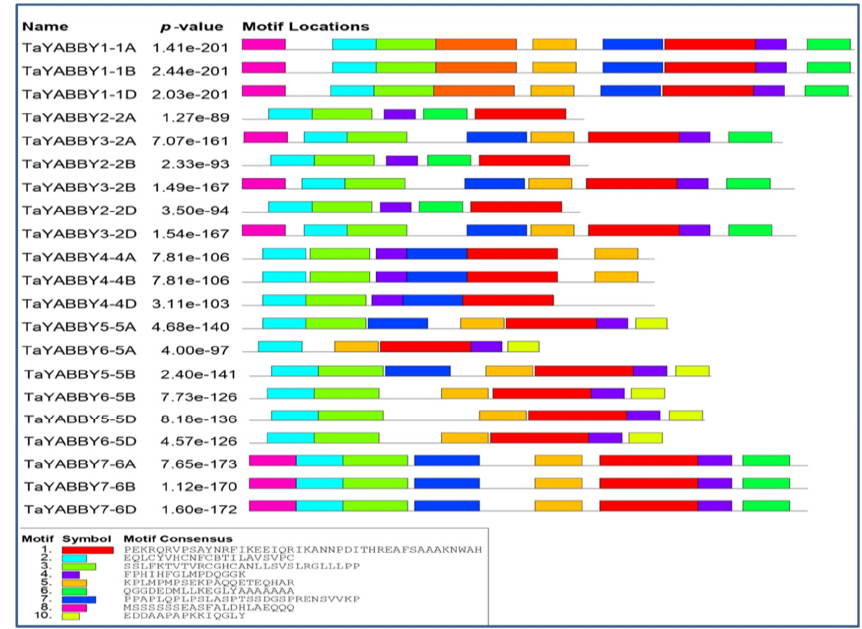
Figure 3. Schematic representation of the conserved motif of TaYABBY -genes.